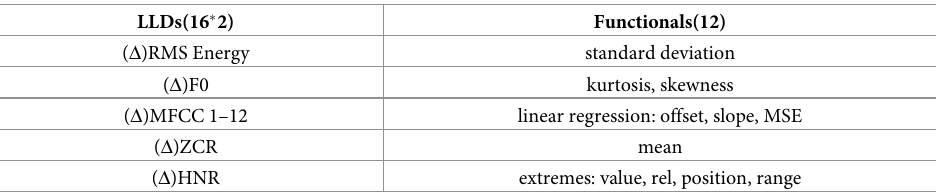
Table 2. LLDs and